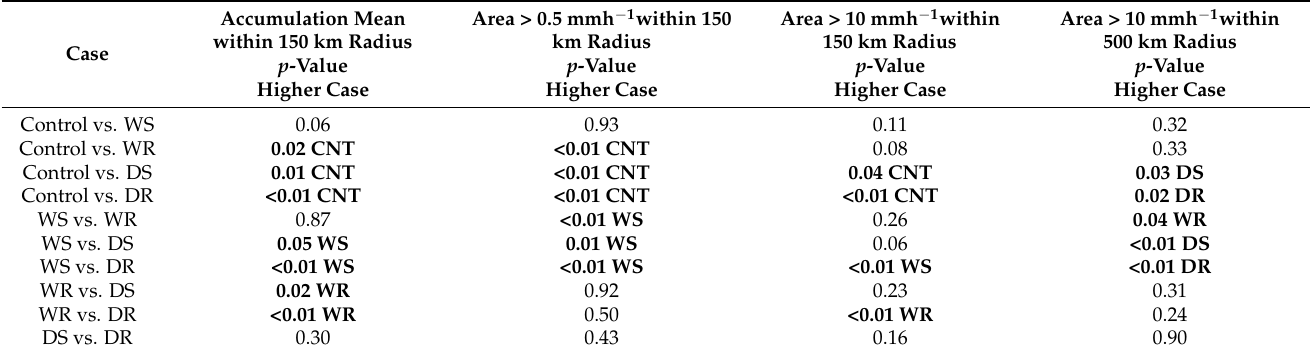
Table 6. Kruskal–Wallis test p -values for average hourly precipitation accumulation (mm) of non-zero area and precipitation coverage (km 2 ) for rain rates >0.5 mm h − 1 and >10 mm h − 1 within 150 km radius and 500 km radius for 25 August to 28 August ( n = 71), bold p -value < 0.05. Distance from the Accumulation Mean Area > 0.5 mm h − 1 p -Value Center <0.01 0.01 Table 7. Results of pairwise comparisons for hourly precipitation accumulation for inner core area within 150 km from 0000 UTC 25 August to 0000 UTC 28 August. Bold signifies p -value < 0.05 and those cells include the case with the higher median value of the